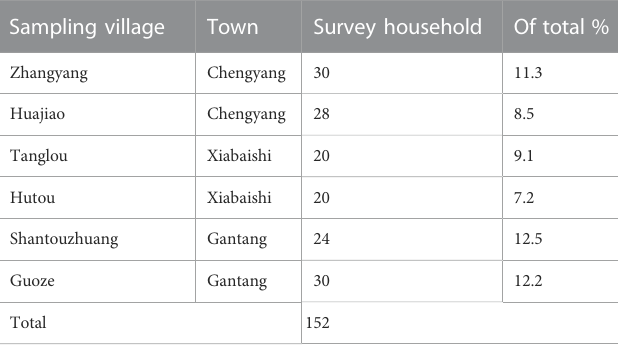
TABLE 1 Number of questionnaires in the sampling villages of Fu ’ an City, China. Sampling village